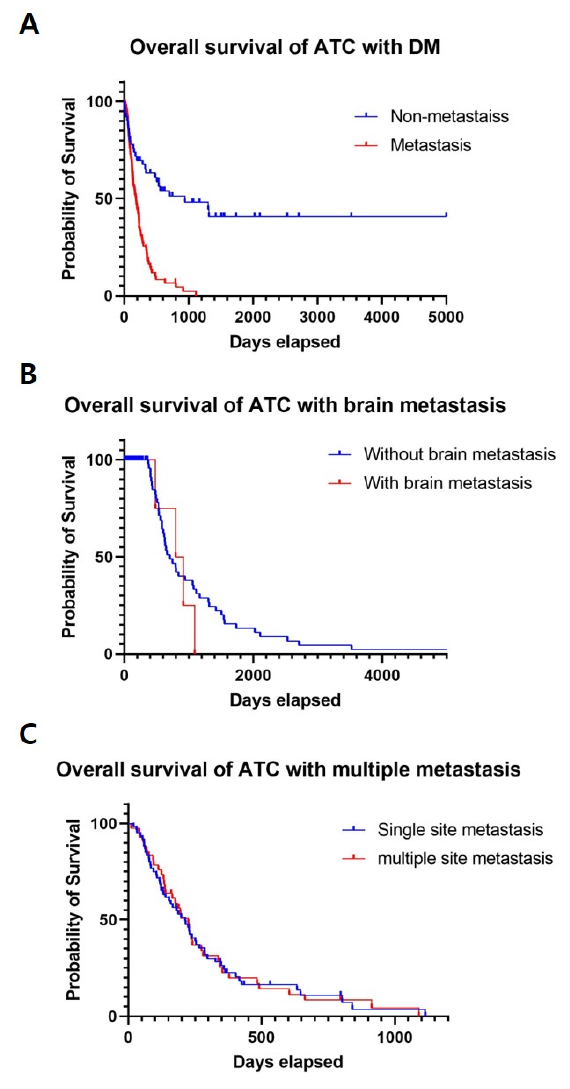
Figure 1. ( A ) Overall survival of ATC with and without distant metastasis, ( B ) Overall survival of ATC with and without brain metastasis, ( C ) Overall survival of ATC with single site metastasis and multiple site metastasis. ATC, Anaplastic thyroid cancer; DM, Distant metastasis.